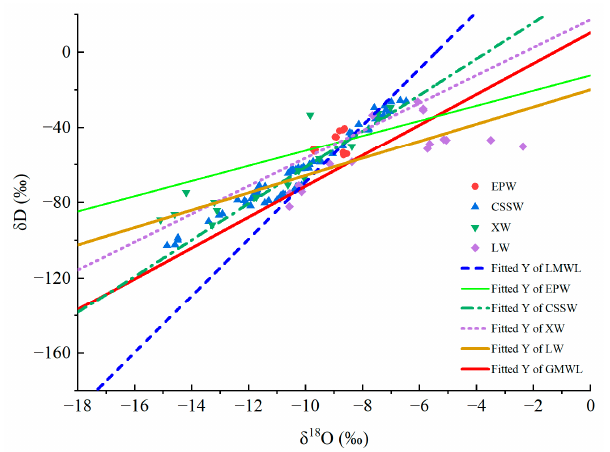
Figure 10. Linear relationship of δ D and δ 18 O in soil water (CSSW), xylem water (XW), leaf water (LW), local atmospheric precipitation (LMWL), global atmospheric precipitation (GMWL) and epikarstic water (EPW).